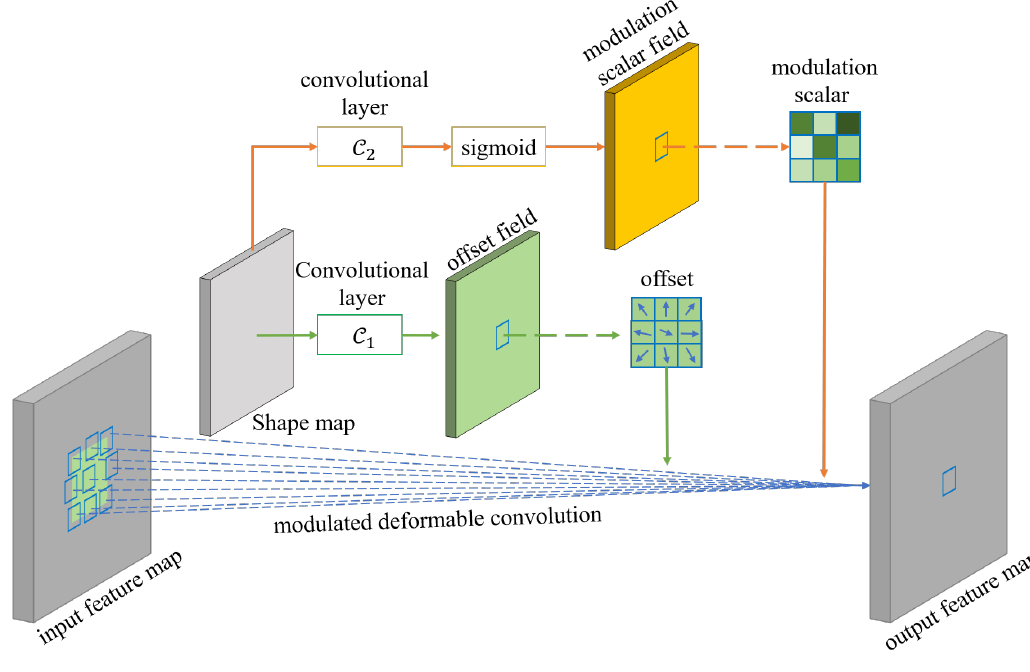
Figure 5. The diagram of modulated feature adaptation in the proposed